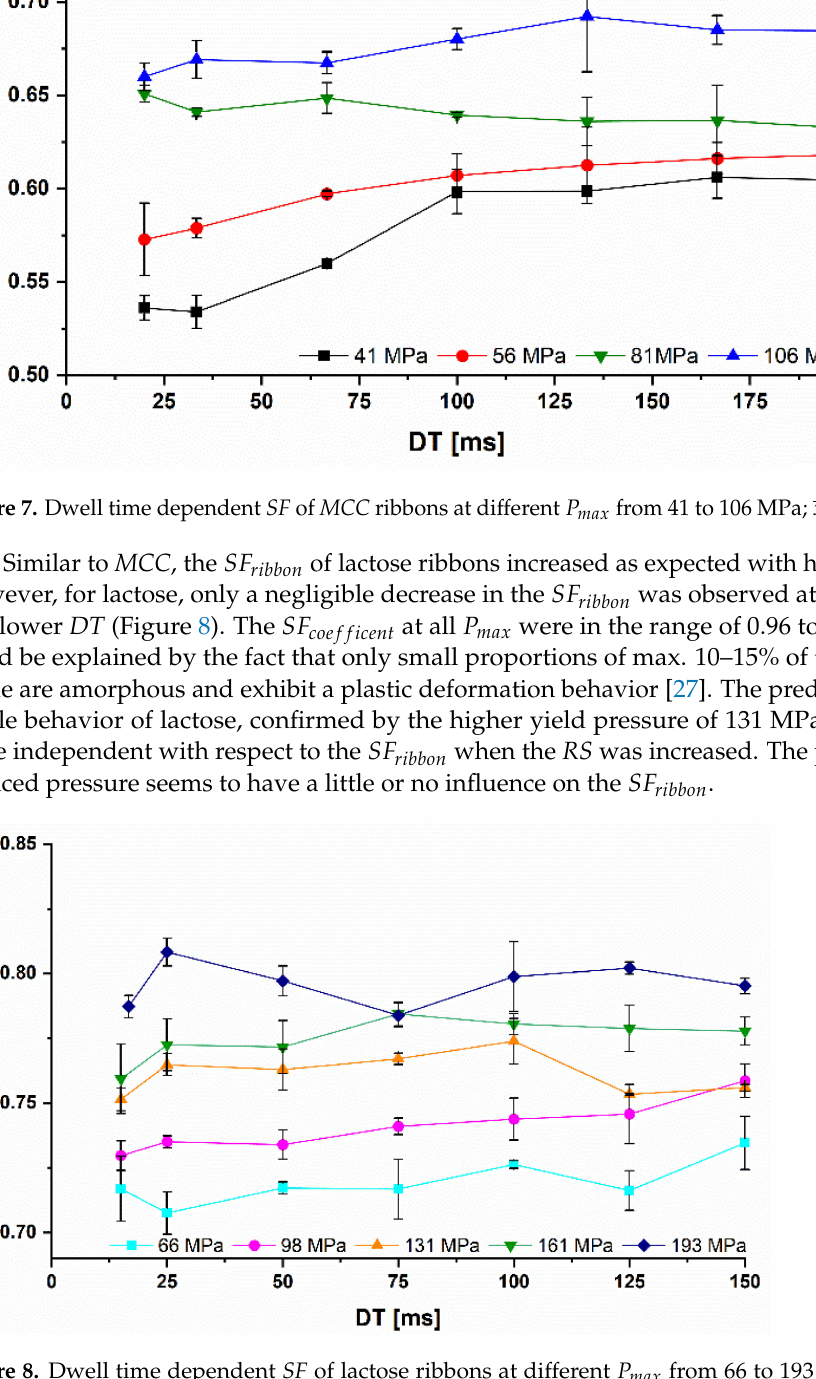
Figure 8. Dwell time dependent SF of lactose ribbons at different P max from 66 to 193 MPa; x ± s ; n =